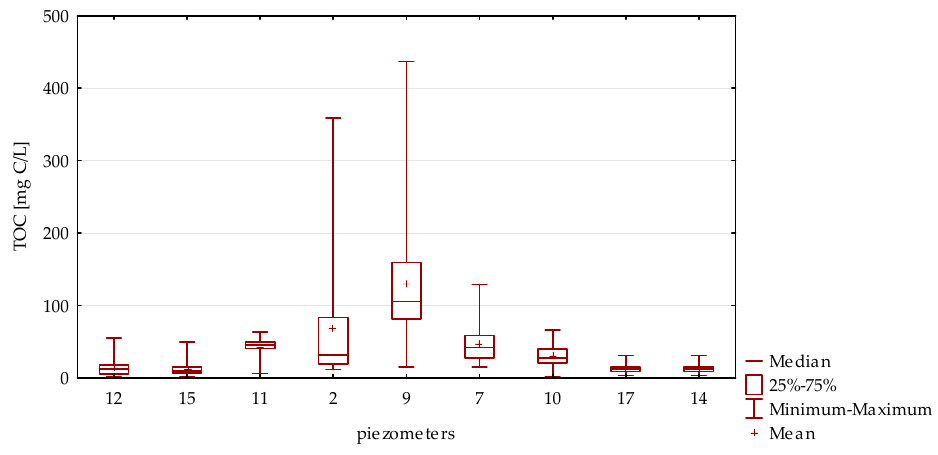
Figure 17. Box-and-whisker plots of the TOC level in particular piezometers.